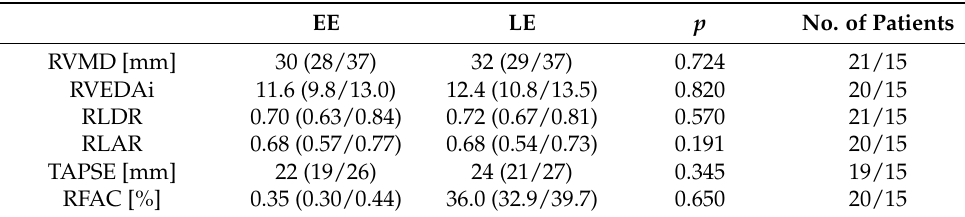
Table 6. TTE evaluated parameters for right ventricular function, survivors compared to nonsurvivors at EE. Survivors p